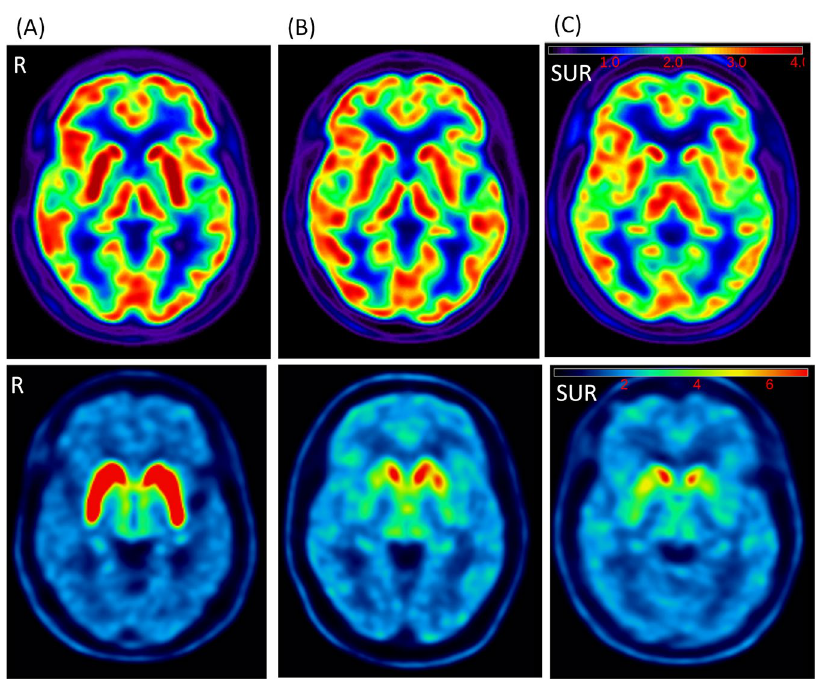
Figure 2. Examples of the early phase (upper row) and late phase (lower row) of 18 F-DTBZ PET images of a control ( A ), a patient with mild PD ( B ) and a patient with severe PD ( C ). Tracer uptake was retained in the bilateral caudate and left anterior putamen regions in mild PD (Hoehn and Yahr stage = 1), but was limited to a partial region of the caudate in severe PD (Hoehn and Yahr stage = 4). Colorbar scale represents as the SUR values. R:right